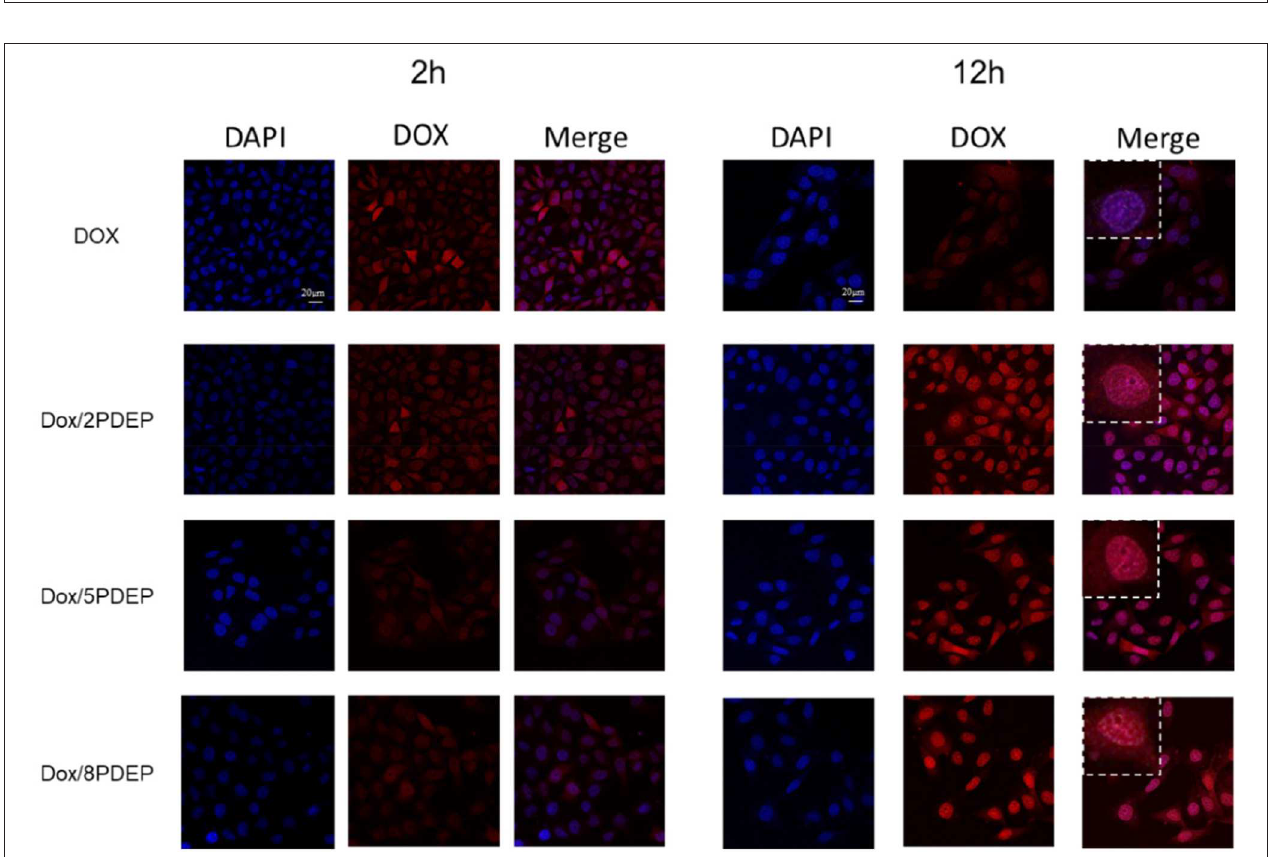
FIGURE 7 | Confocal images of HepG2 cells incubated with DOX (1 µ g · mL − 1 ) and PDEP micelles (5 µ g · mL − 1 ) loaded with DOX (1 µ g · mL − 1 ) after 2 or 12h.